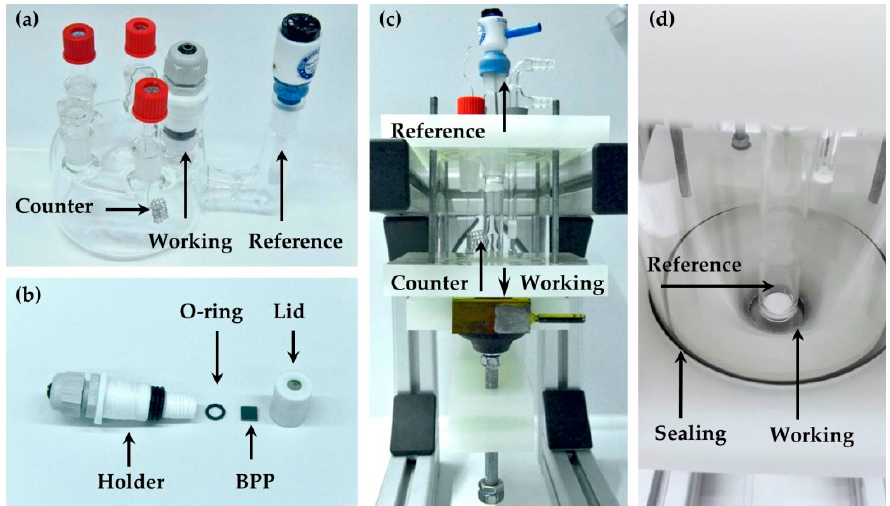
Figure 1. ( a ) Electrochemical set-up A; ( b ) sample holder in set-up A; ( c ) electrochemical set-up B; and ( d ) sample holder in set-up B. BPP, bipolar plate.